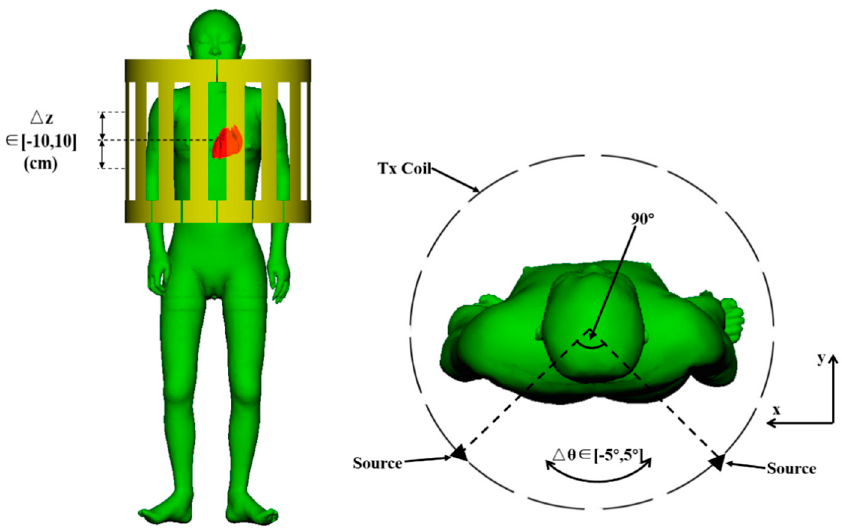
Figure 3. Positioning of the human models in the coil.